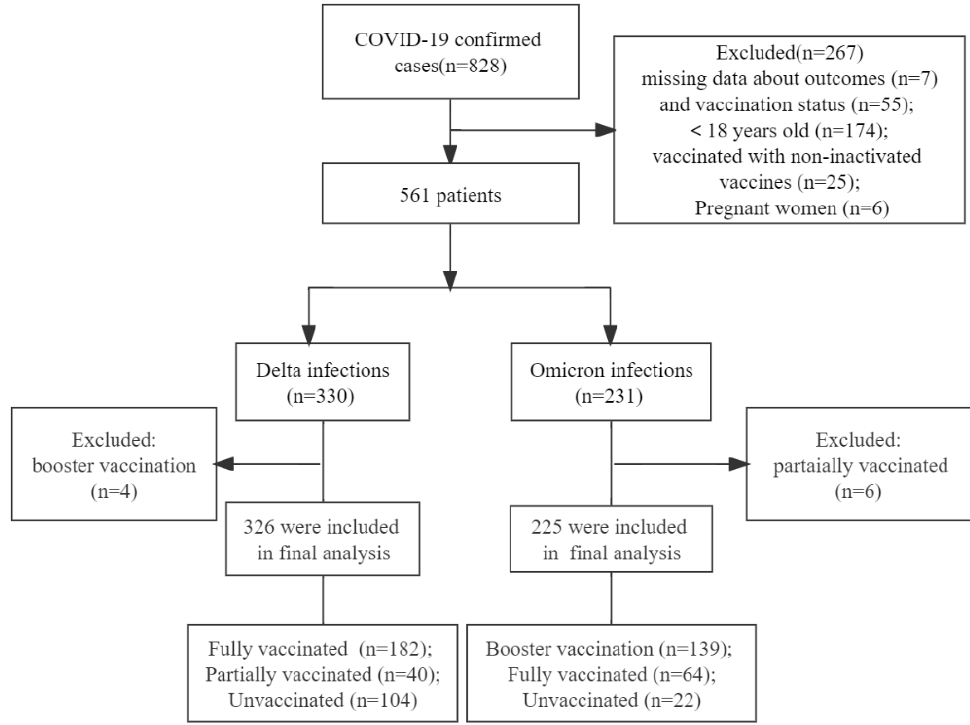
Figure 1. Study flow chart.